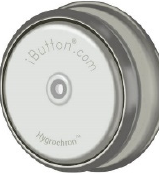
Figure 6. Maxim Integrated iButton DS1923 sensor.